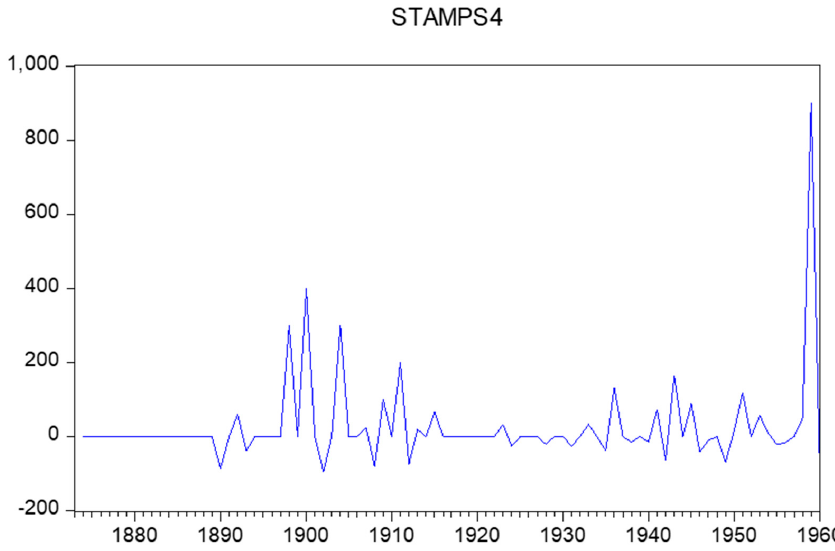
Figure 7. Percentage changes in postal stamps prices, 1873–1960.